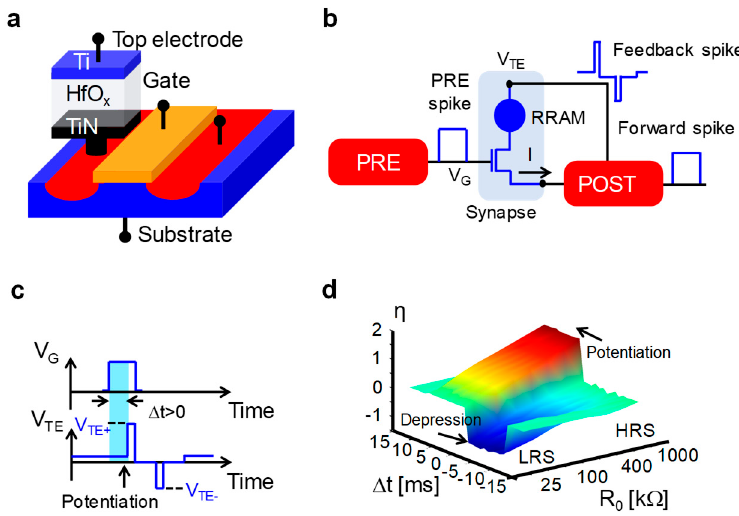
Figure 15. ( a ) Schematic structure of the 1T1R RRAM structure. ( b ) Schematic representation of the 1T1R structure as a synapse to achieve STDP in hardware via overlapping PRE and POST voltage spikes applied at the gate terminal and RRAM top electrode, respectively. ( c ) Schematic sketch of PRE and POST overlapping spikes leading to synapse potentiation via the activation of a set process in the RRAM cell. ( d ) STDP characteristics experimentally demonstrated in the 1T1R RRAM synapse. Adapted with permission from [151,152]. Copyright 2016, IEEE.